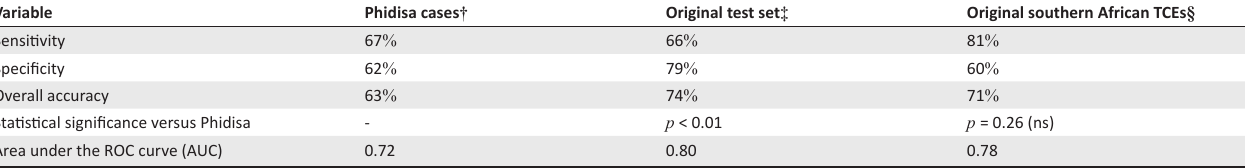
TABLE 2: Results of testing the models with the original independent test cases and the 402 Phidisa cases. Variable